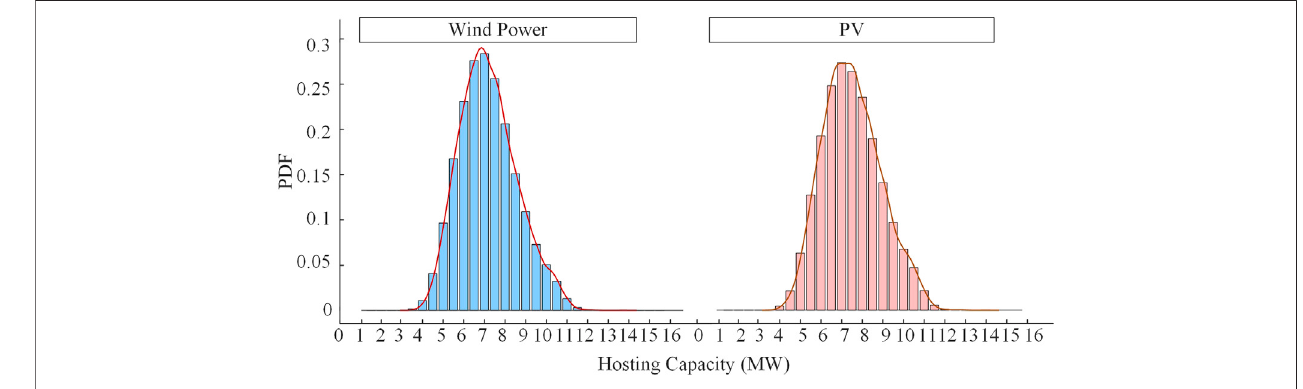
FIGURE 8 | PDF under 50% penetration level.